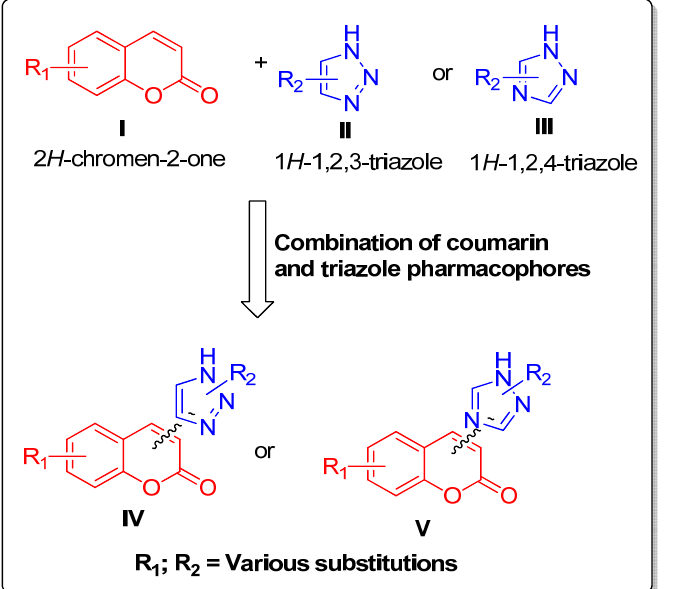
Figure 2. Combination of coumarin and triazole moieties to obtain a more effective single-drug